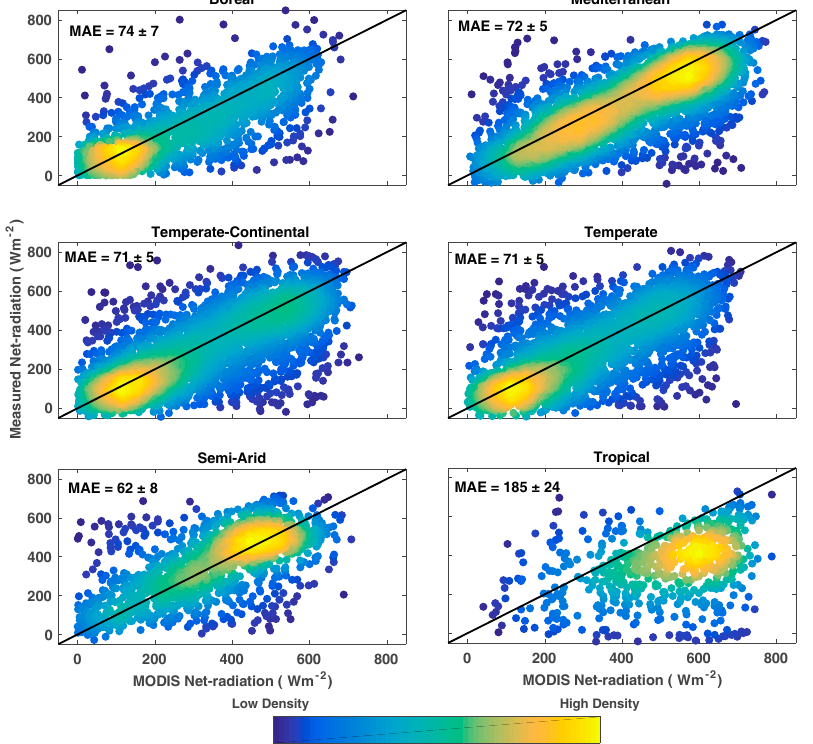
Figure 3. Comparison between MODIS and measured instantaneous net-radiation at Terra overpass time in six different climate types. MAE denotes mean absolute error estimate in W ∙ m − 2 .